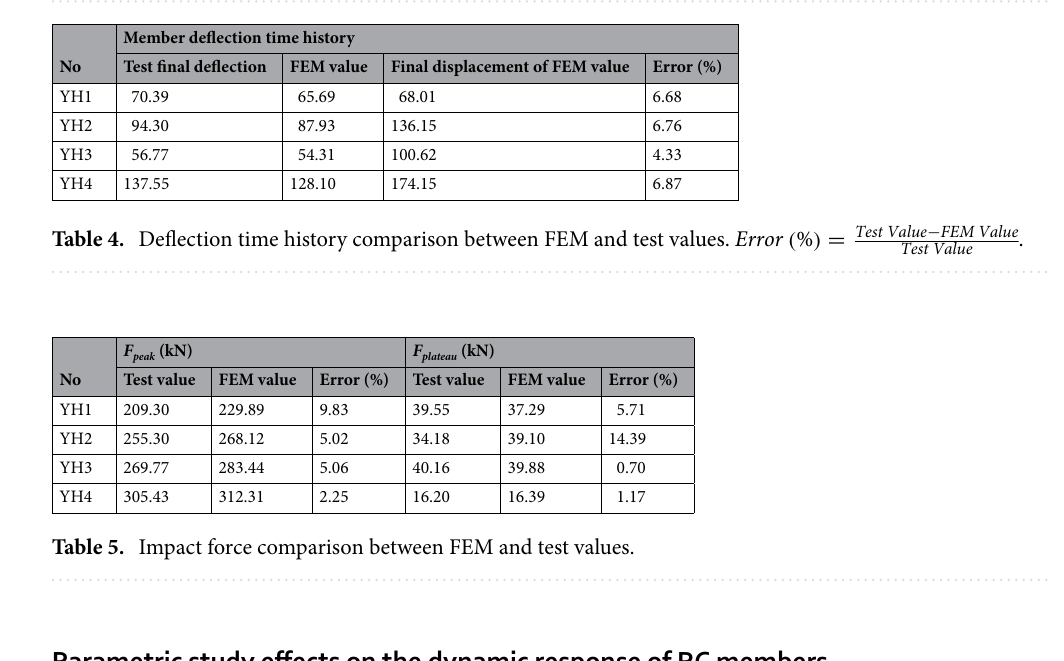
Figure 8. Comparison of impact force–time history curves.